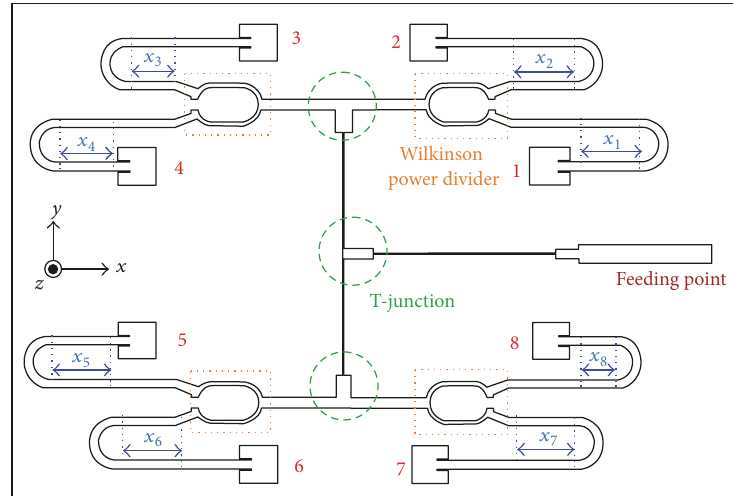
Figure 7: Layout of UCA and feeding network.